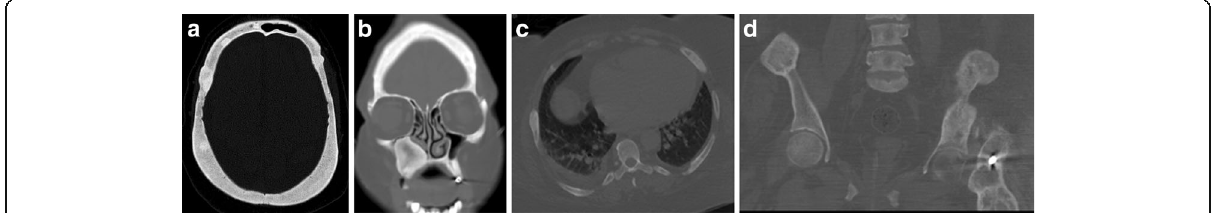
Fig. 11 CT showed multiple expansile mixed lytic/sclerotic lesions in the calvarium, right maxillary antrum, ribs and iliac crests bilaterally